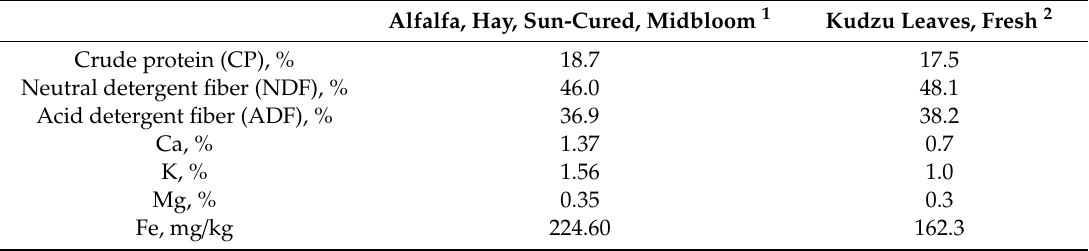
Table 2. Nutrient composition of alfalfa hay and fresh kudzu ( P. montana ) leaves (dry matter (DM))